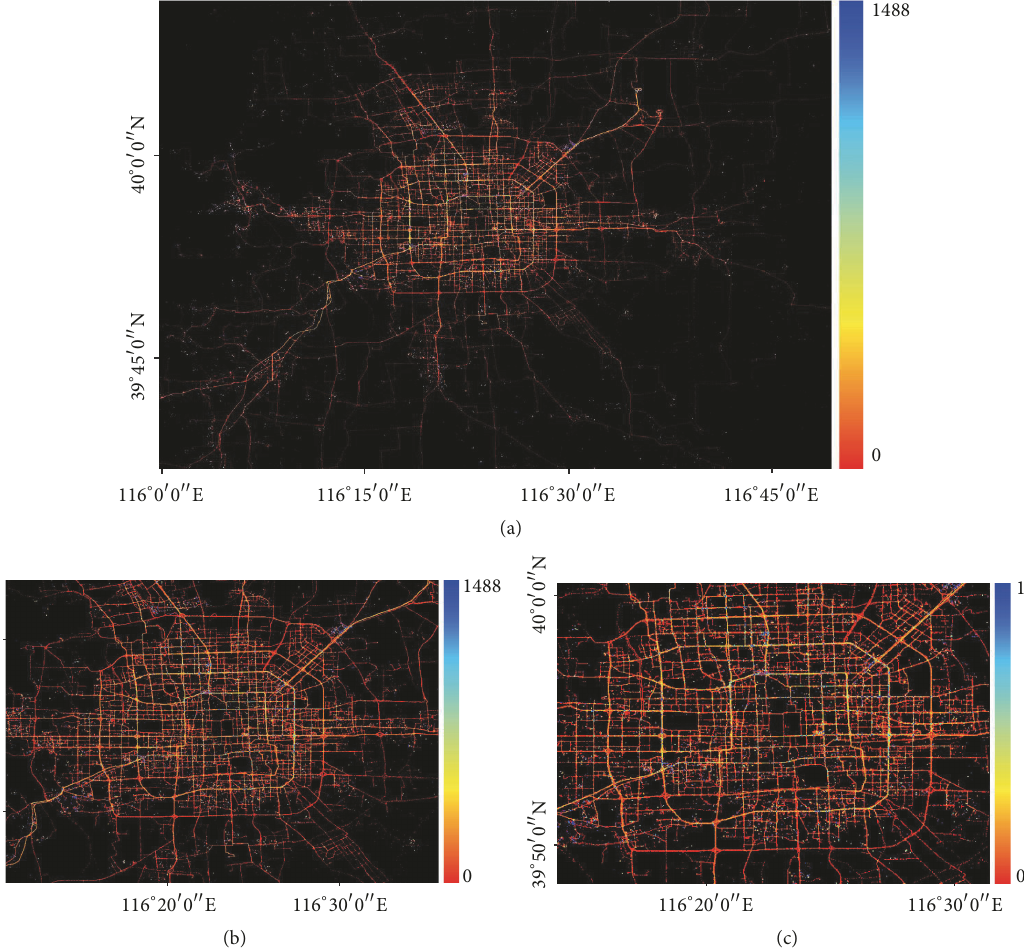
Figure 1: Distribution of the GPS points (1,232,048 records) generated by 12,000 taxicabs in Beijing at 00:14:35 AM-01:14:34 AM on 1 November 2012, where the color denotes the density of the points. (a) Data overview in Beijing. (b) Within the 5th Ring Road and (c) the 4th Ring Road of Beijing. Figure reproduced from Xia et al. (2016) [13]. Copyright ©2016 IEEE, with